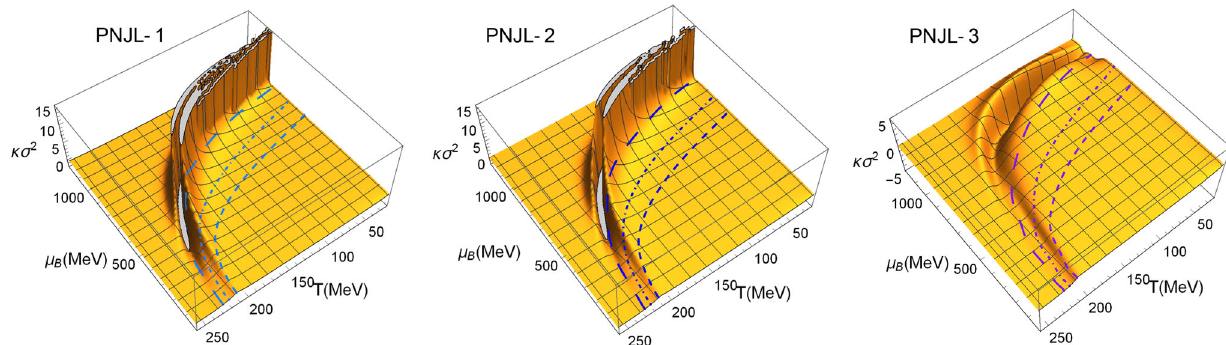
Fig. 4 The 3D plot for the kurtosis of baryon number fluctuation κσ 2 as a function of the temperature and baryon chemical potential in the PNJL model. The long dashed, dashed-dotted and dashed lines in each